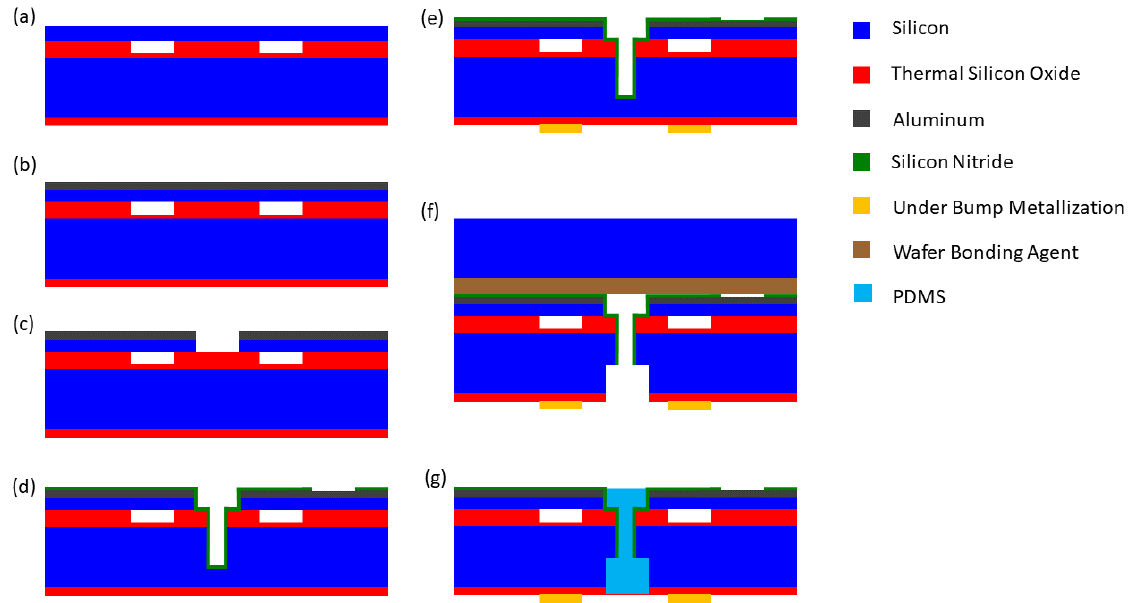
Figure 11. Process flow for fabricating a bendable CMUT array. ( a ) A wafer-bonded CMUT after stripping the SOI BOX. ( b ) Sputtering top-side metallization. ( c ) Top-side isolation etch. ( d ) Second top-side isolation with nitride passivation. ( e ) Deposit of under bump metalization (UBM). ( f ) Secure to supporting wafer. ( g ) Back-side isolation and polydimethylsiloxane (PDMS)